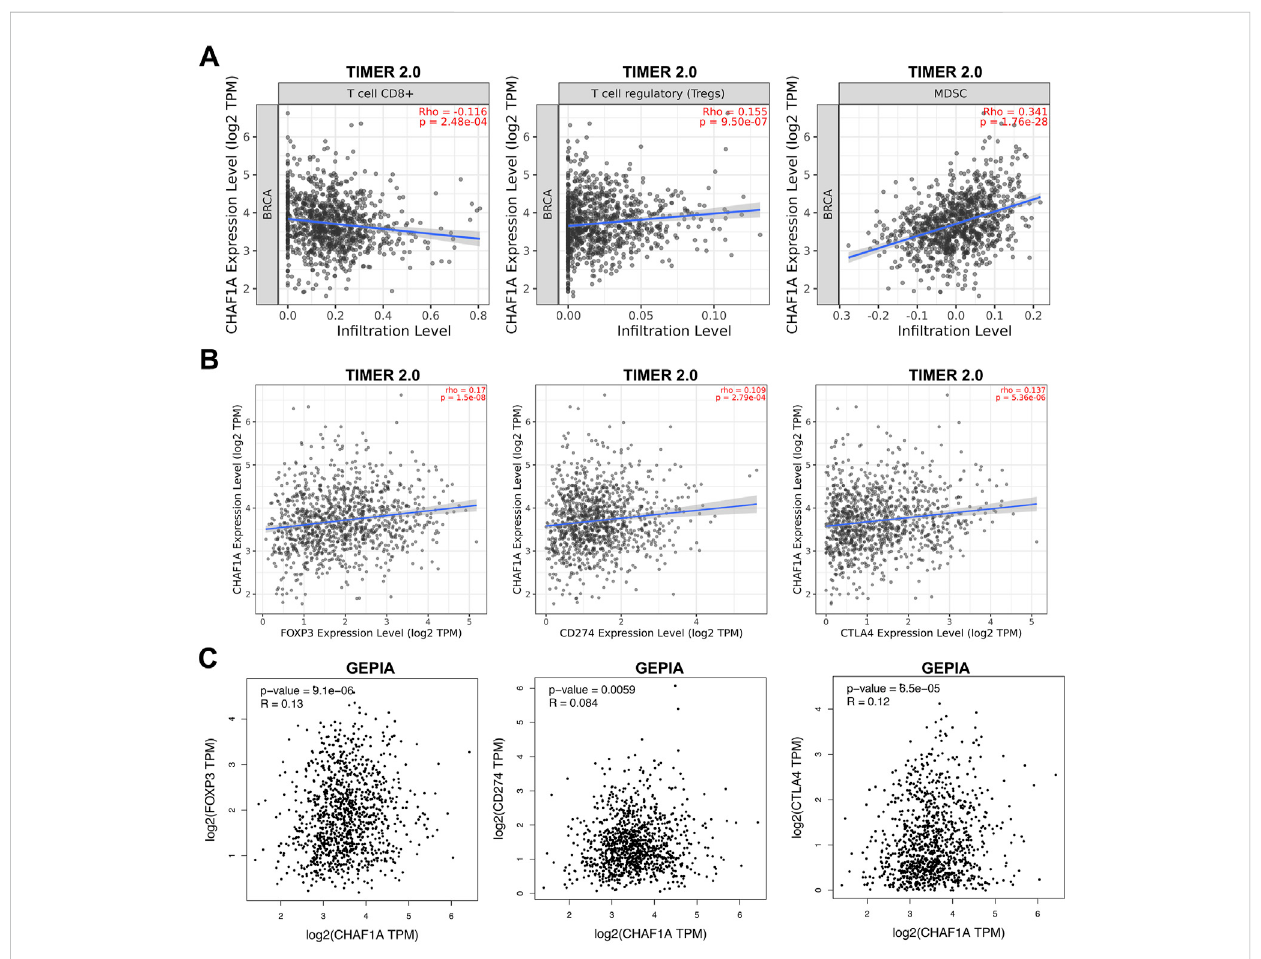
FIGURE 4 The correlation of CHAF1A with immune in fi ltrating cells and with immune checkpoint markers in breast cancer tissues. (A) Higher expression of CHAF1A was negatively associated with cancer in fi ltrating CD8 + T cells, but positively associated with in fi ltrating regulatory T cells and MDSC cells in breast cancer as indicated in TIMER 2.0 database. (B) The expression of CHAF1A was positively correlated with the expression of CD274 and CTLA4 in breast cancer in TIMER 2.0 database. (C) The expression of CHAF1A was positively correlated with the expression of CD274 and CTLA4 in breast cancer in GEPIA